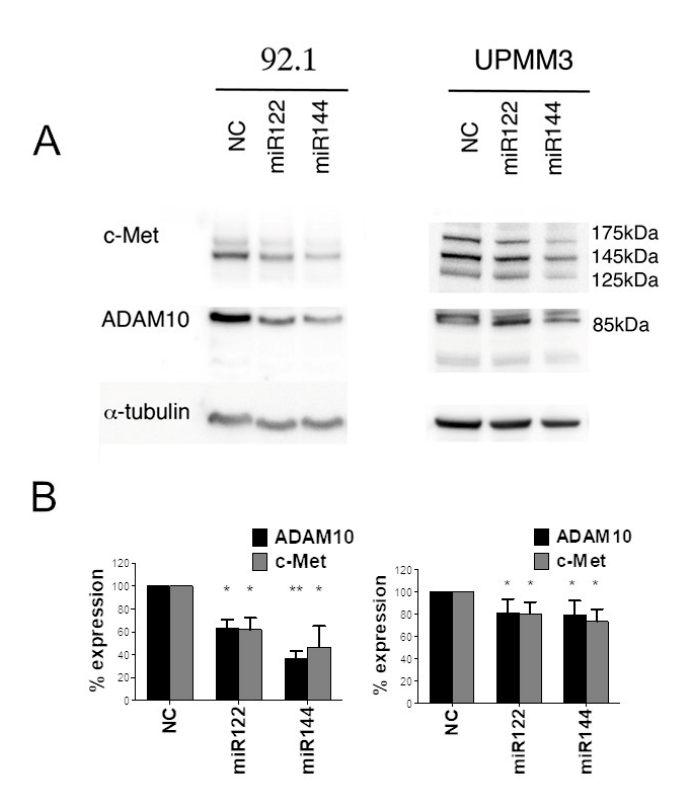
Figure 4. Western blot analysis of ADAM10 and c-Met expression of miR122 and miR144 transfected cells. ( A ): Western blot analysis shows expression of ADAM10 and c-Met proteins in 92.1 and UPMM3 cell lines, upon transfection with mimic miR122, miR144 or an irrelevant miR control (NC). α -tubulin was used as loading control. Cropped images are obtained from the same blot subsequently probed with the different antibodies. Molecular weight markers are shown. ( B ): histograms show the quantification of band intensity expressed as percentage of the irrelevant miR transfected control (NC). Mean ± sd of three independent experiments. (* p < 0.05; ** p < 0.01).